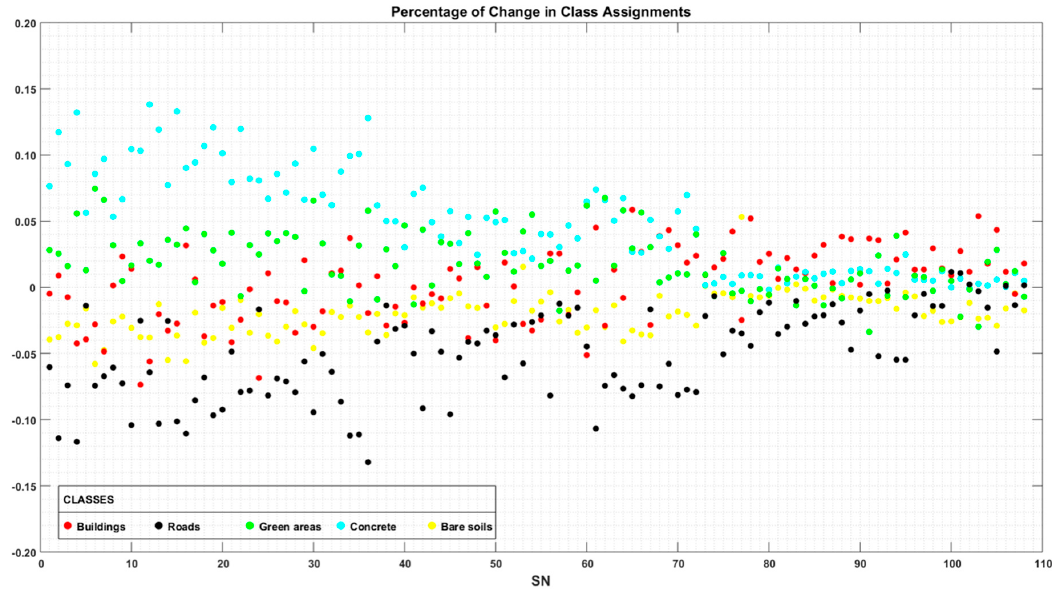
Figure 16. Percentage of change in class assignment in classifications based on SSM 3.